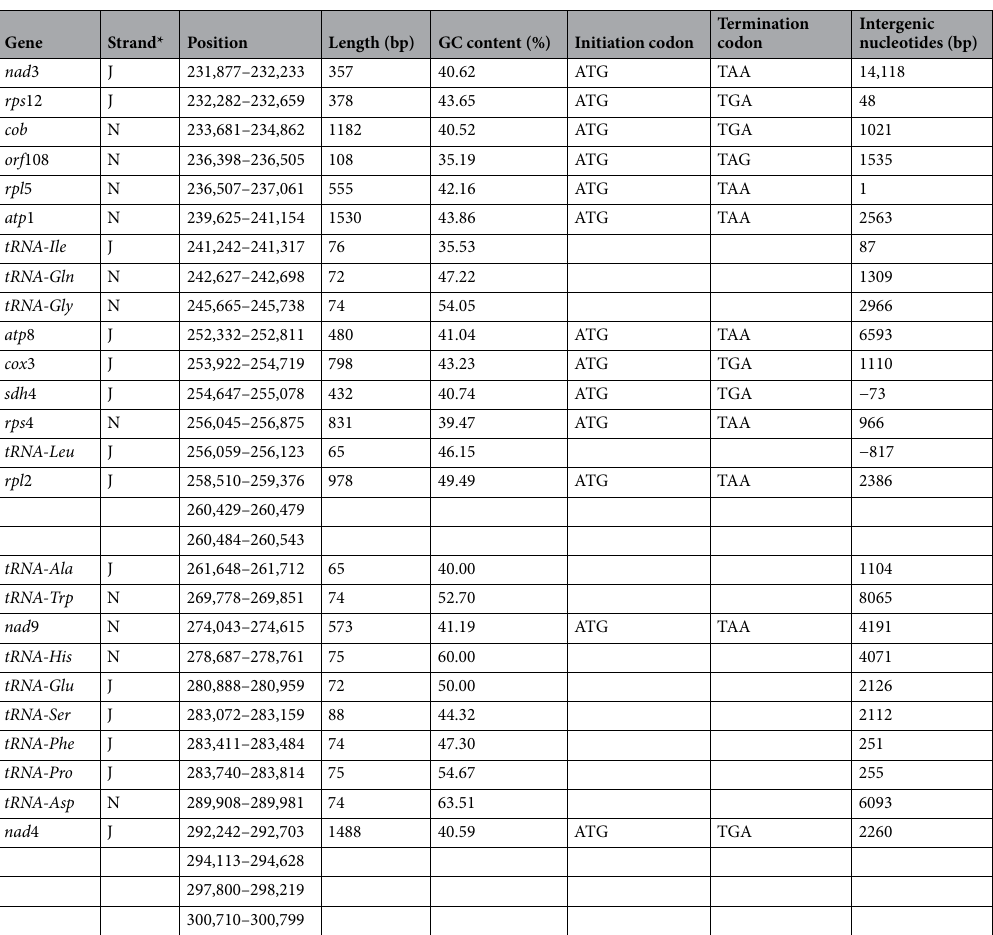
Table 2. Annotations and characteristics of mitochondrial genome 2 of Neolamarckia cadamba. *J stands for the direction of a gene from 5 ′ to 3 ′ , and N for the direction of a gene from 3 ′ to 5 ′